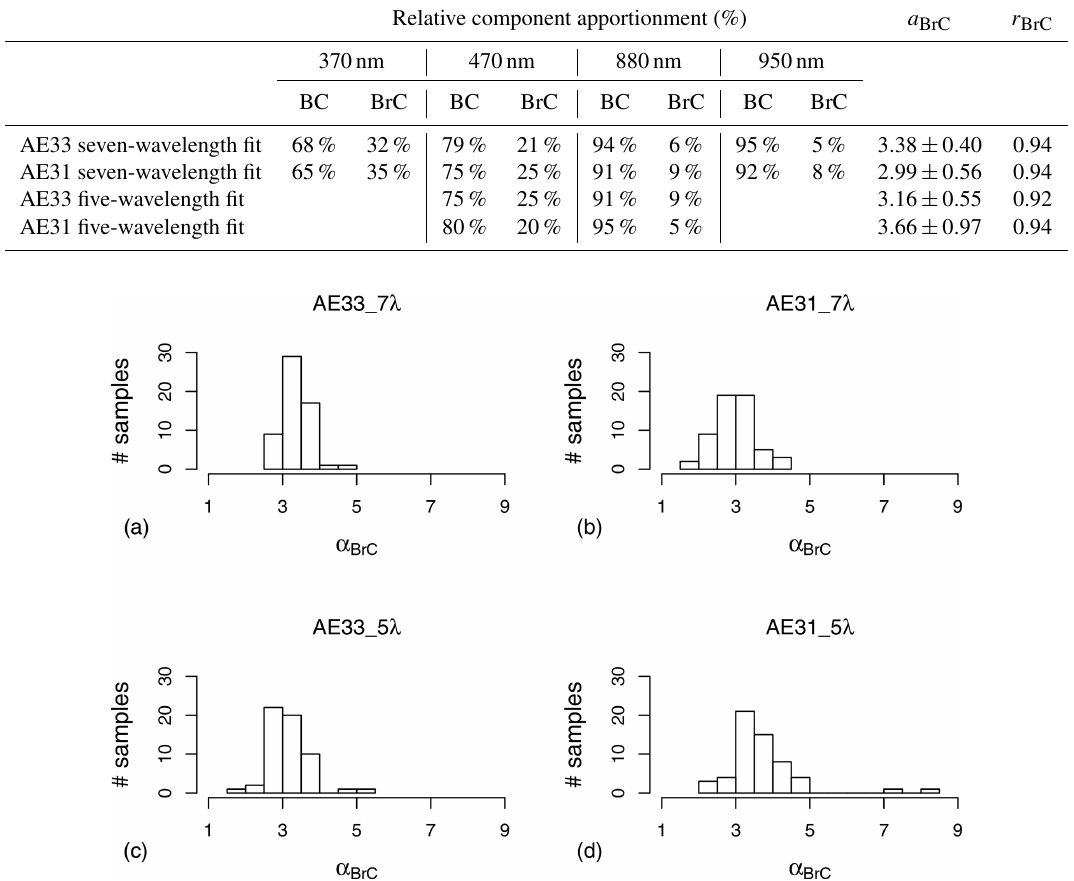
Figure 6. Frequency distribution of α BrC computed by MWAA model for AE33 (a, c) and AE31 (b, d) . A seven-wavelength b abs fit was performed in (a, b) , and a five-wavelength fit was performed in (b, d)